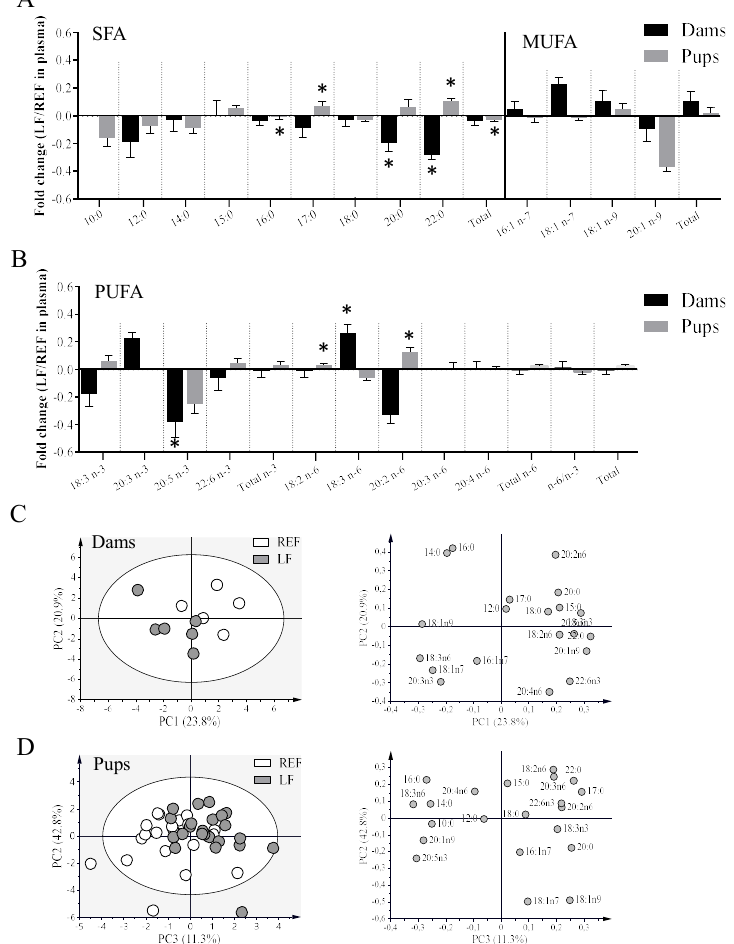
Figure 4. Fatty acid profile in serum of dams and pups at L14. ( A ) Saturated (SFA) and monounsaturated (MUFA) fatty acids, ( B ) polyunsaturated (PUFA) fatty acids were quantified by GC-FID. The analysis of principal components was performed for both ( C ) dams’ and ( D ) pups’ samples and represented in score and loading plots. Fatty acid data was mean centered and scaled to unit variance. The % of explained variance is presented in parentheses. Results are expressed as mean ± S.E.M. ( n = 6 dams/group and n = 24 pups/group). The fold change was calculated in respect to REF group. REF, reference group; LF, Lactobacillus fermentum CECT5716 group. * p < 0.05 compared to REF.